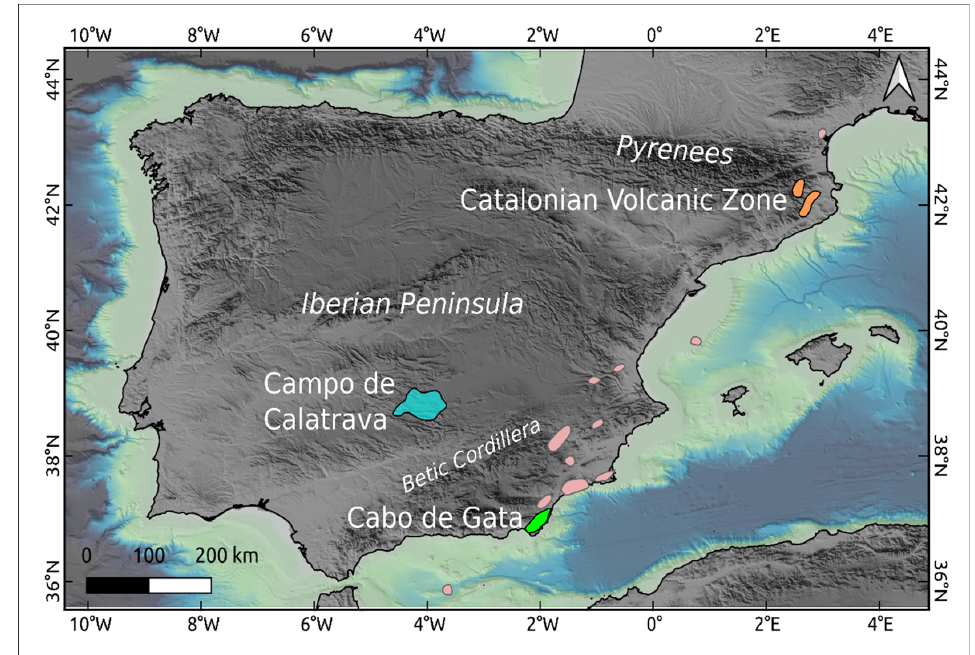
Figure 1. Location of the Iberian volcanism modified from Granja-Bruña et al. 2015 [61]. Study areas are shown in blue, green, and orange. Volcanic areas not included in this study are displayed in pink.